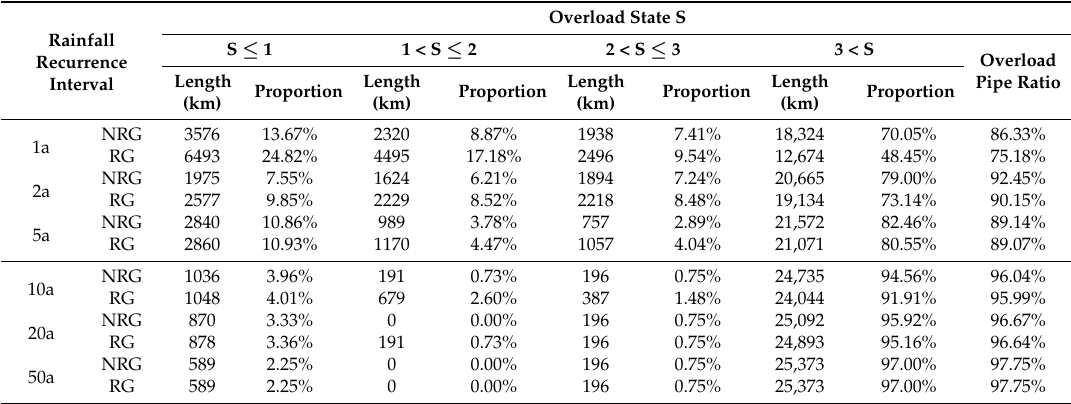
Table 3. Statistical table of pipe network overload